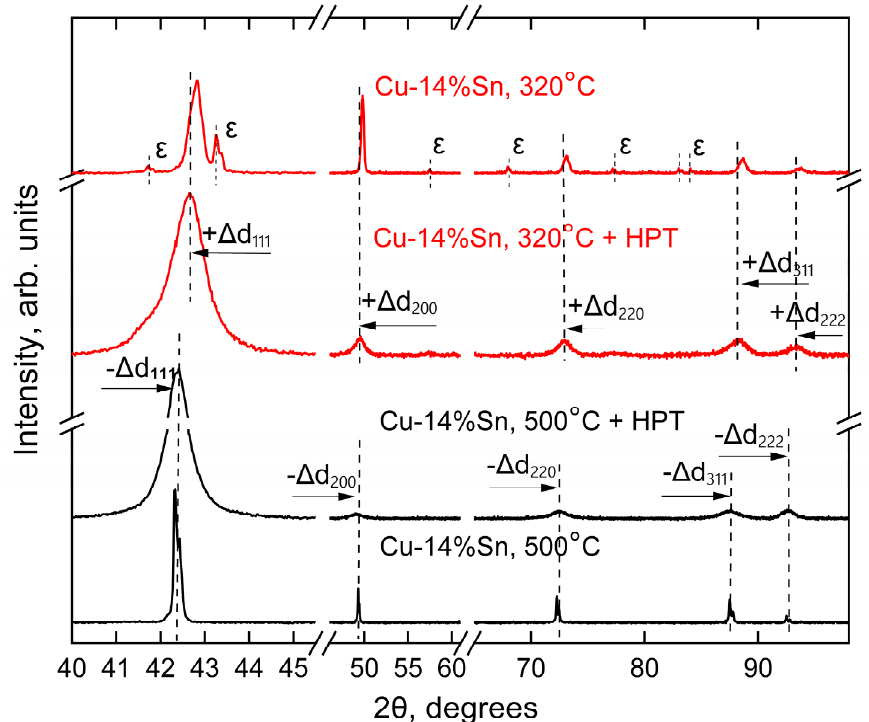
Figure 5. X-ray diffraction patterns of the Cu–14 wt% Sn alloy annealed at 320 ◦ C (red curves) before HPT (top red curve) and after HPT (bottom red curve), as well as at 500 ◦ C (black curves) before HPT (bottom black curve) and after HPT (top black curve). Vertical dotted lines and arrows show the peak shift after HPT.